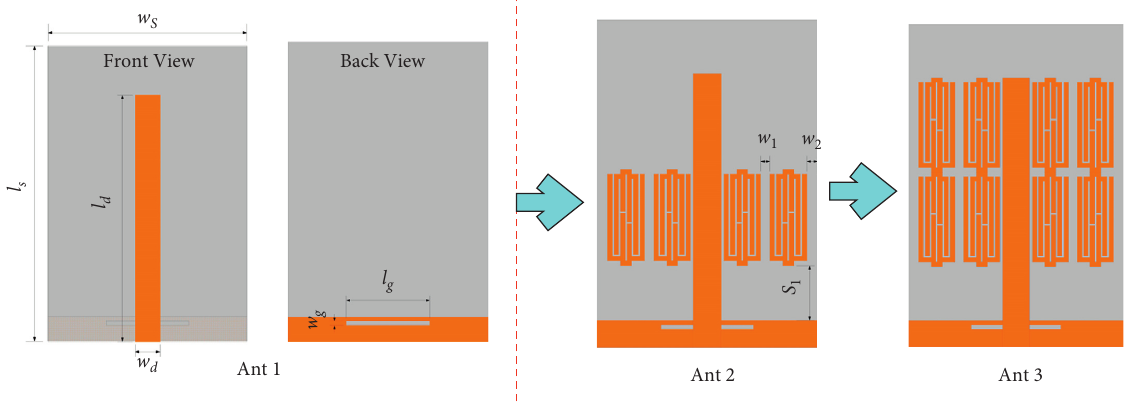
Figure 4: Design procedure of the proposed antenna.